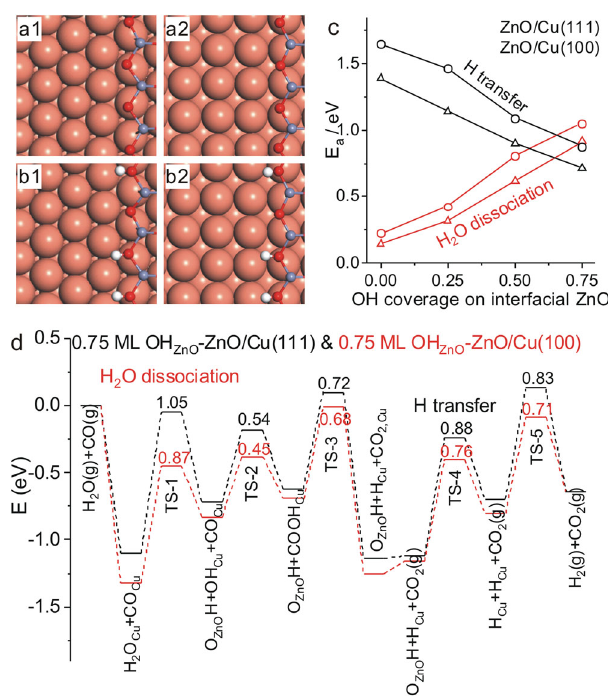
Fig. 5 DFT calculations of WGS reaction. Optimized surface structures of a1 ZnO/Cu(111), a2 ZnO/Cu(100), b1 0.75 ML-OH ZnO -ZnO/Cu(111) and b2 0.75 ML OH ZnO -ZnO/Cu(100). The reddish-orange, purple, red, and white spheres represent Cu, Zn, O, and H atoms, respectively. c Calculated activation energy of H 2 O dissociation and OH ZnO -to-H Cu H transfer reaction at ZnO-Cu interface as a function of the OH coverage on interfacial ZnO of ZnO/Cu(111) and ZnO/Cu(100) surfaces. The OH coverage is de fi ned as the ratio of OH number against total O number at the ZnO-Cu interface. d Calculated energy pro fi les of WGS reaction catalyzed